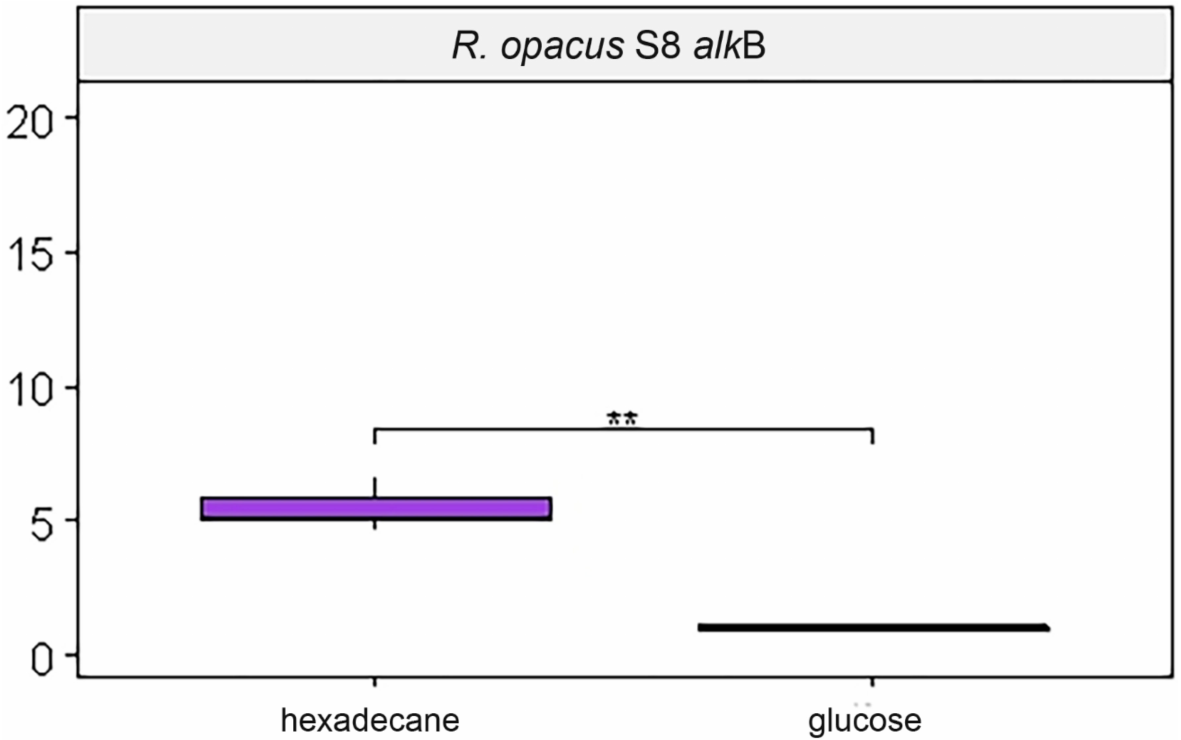
Figure 3. Real-time PCR. The relative amount of mRNA genes. ** p ≤